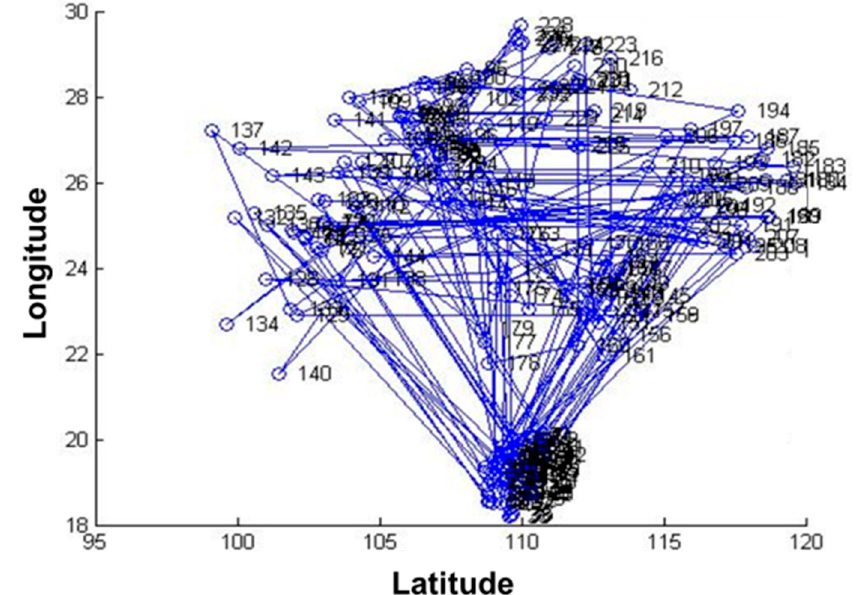
Figure 8. Running results of simulated annealing.